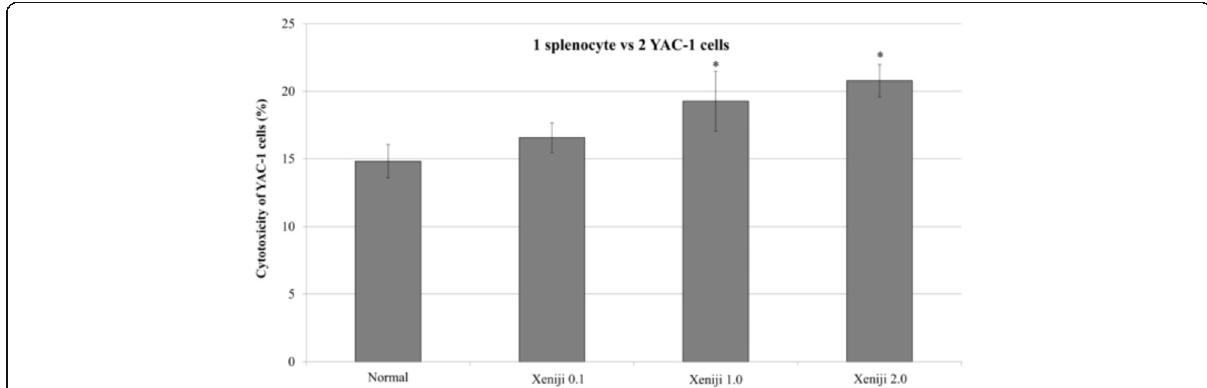
Fig. 6 Cytotoxicity of splenocytes on YAC-1 cells at ratio 2 to 1. * indicates a significant difference compared with the normal control group, p <